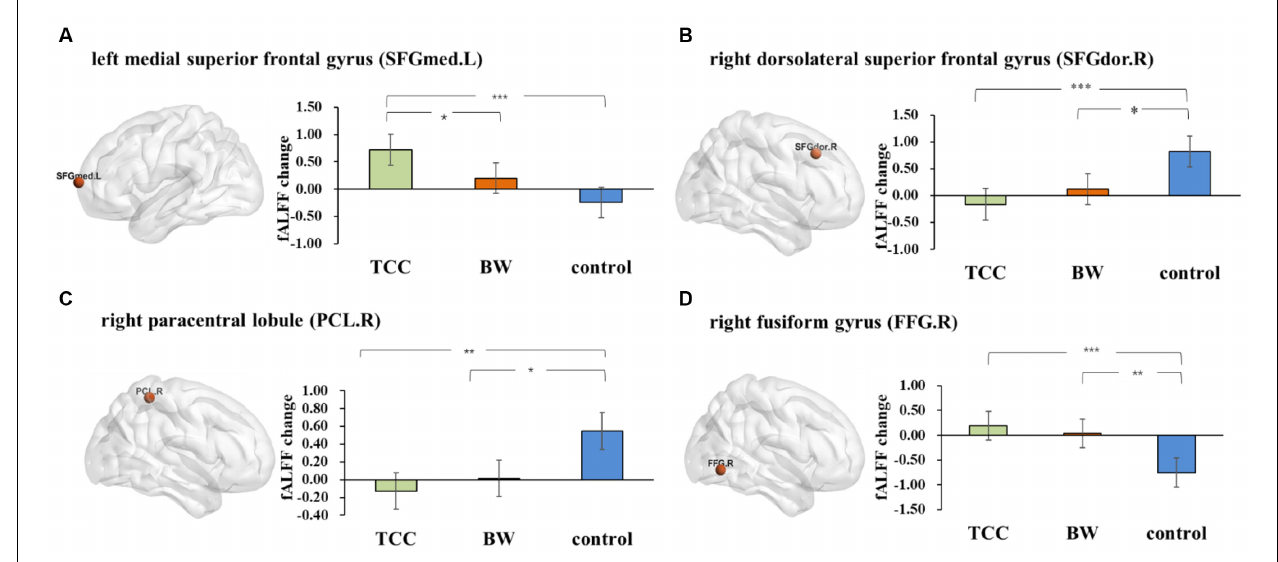
FIGURE 2 | The fractional amplitude of low-frequency fluctuations (fALFF) results. Changes in the fALFF after 8 weeks of Tai Chi Chuan (TCC) and BW. (A) Post hoc statistical analysis results of fALFF changes in the SFGmed.L-left medial superior frontal gyrus. (B) Post hoc statistical analysis of the fALFF changes in SFGdor.R-right dorsolateral superior frontal gyrus. (C) Post hoc statistical analysis results of the fALFF changes in the PCL.R-right paracentral lobule. (D) Post hoc statistical analysis results of the fALFF changes in the FFG.R-right fusiform gyrus. * p ≤ 0.05, ** p ≤ 0.01, and ∗∗∗ p ≤ 0.001.